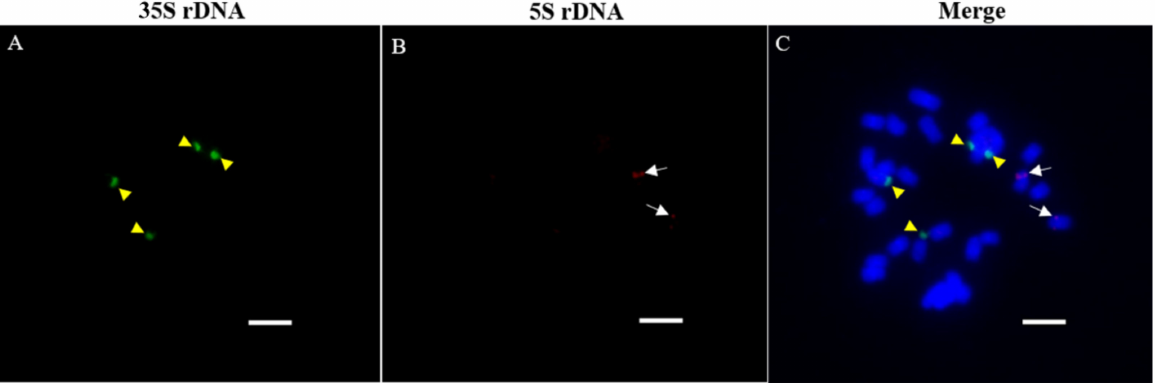
Figure 6. Localization of 35S rDNA and 5S rDNA probes on root-tip mitosis prometaphase chro- mosomes of P. purpureum (2 n = 4 x = 28) by FISH. ( A ) Location of 35S rDNA on prometaphase chromosomes. Yellow arrows indicated 35S rDNA signals (green). ( B ) Location of 5S rDNA on prometaphase chromosomes. Long white arrows indicated 5S rDNA signals (red). ( C ) The merged signals combined 35S rDNA, 5S rDNA and chromosomes (DAPI). Scale bars = 5 µ